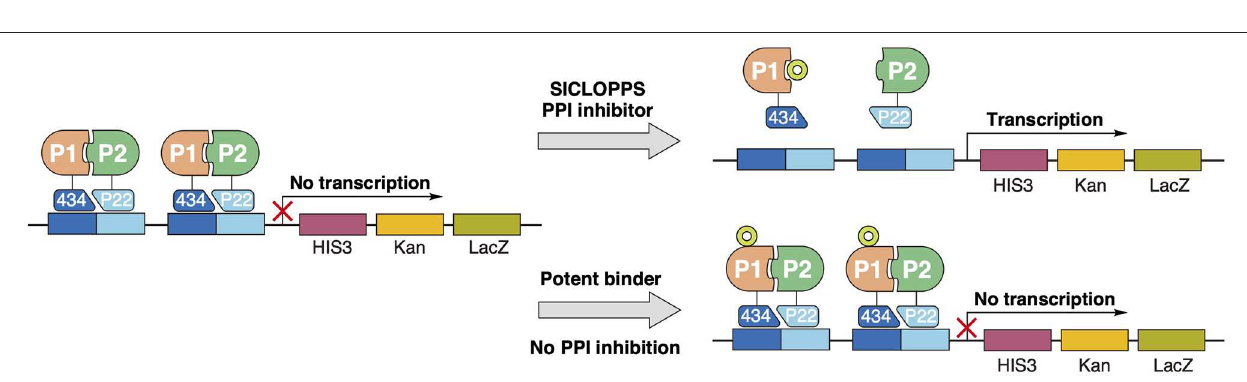
FIGURE 7 | Schematic overview of the molecular processes involved in SICLOPPS to form backbone macrocyclic peptides. Through the utilization of a split-intein system, a macrocyclic intein linked peptide is formed upon complementation of both intein fragments. Intramolecular rearrangements such as N-to-S acyl transfer and asparagine succinimide formation open the opportunity for the now N-terminal Cys to restore the macrocycle by attacking the thioester link on the other side of the randomized region. This eliminates the succinimide tailed intein fragment and leaves, after trans-thioesterification, a Cys linked, genetically encoded backbone macrocyclic peptide that can be used for intercellular screening endeavors.